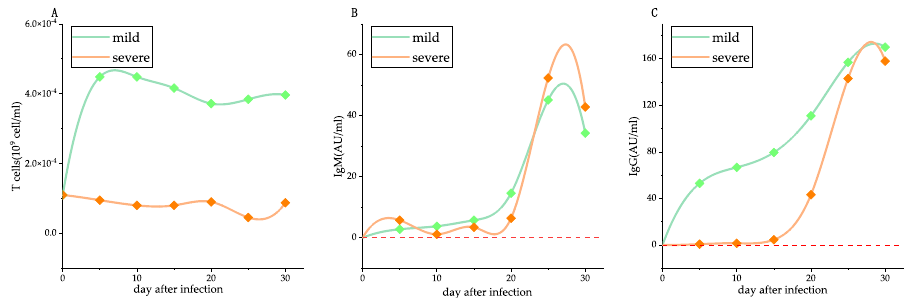
Figure 2. ( A ) Dynamic changes of T cells over time; ( B ) Dynamic changes of IgM over time; ( C ) Dy- namic changes of IgG over time. In this paper, the initial value of T cells is treated as [21], and the initial values of IgM and IgG are treated as 0. Other data are from [30].